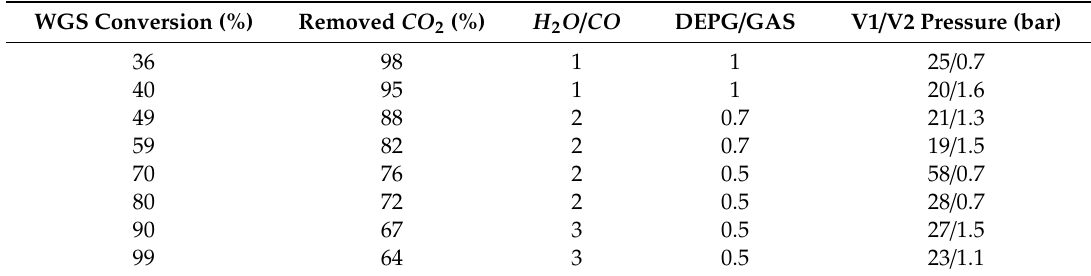
Table 5. Final variable